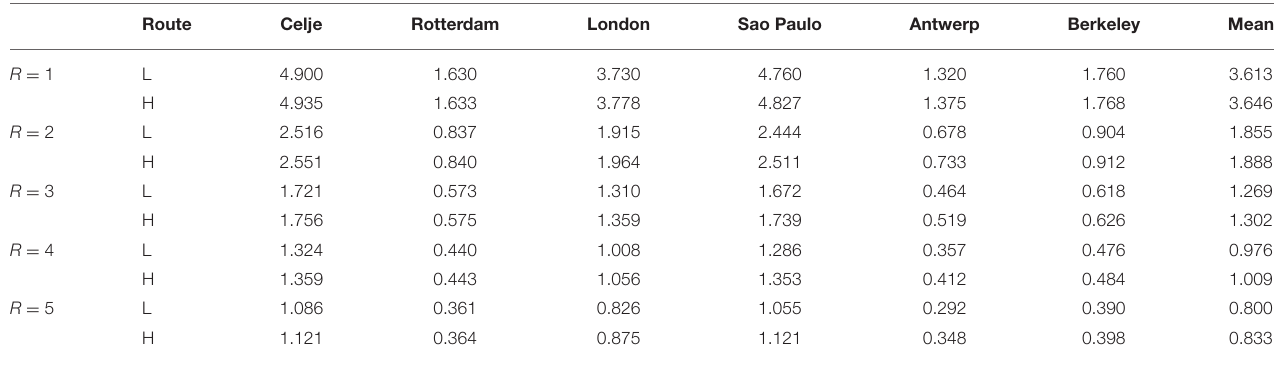
TABLE 3 | Mean annual BC exposure by taking each route (L = low exposure, H = high exposure route, the unit for all numbers is µ g/h.m 3 , R = ratio of mean low exposure route to background). Route